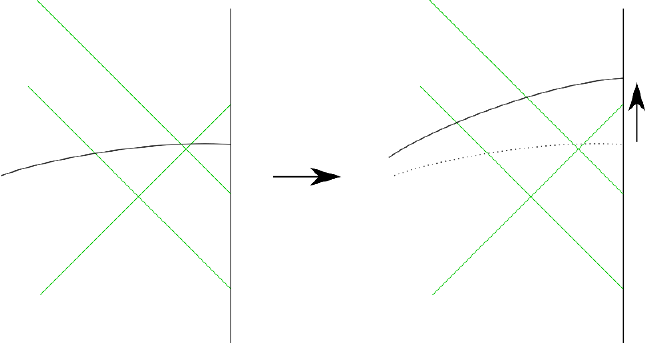
Figure 4 . Illustration of step 2, whereby we simplify the operator by evolving it to a Cauchy slice that crosses fewer